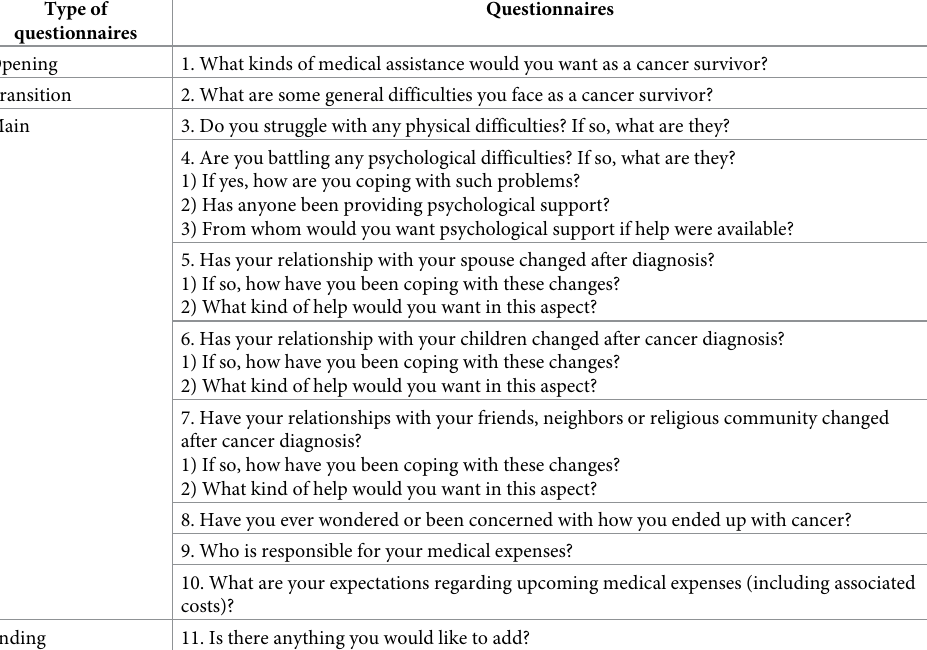
Table 2. List of